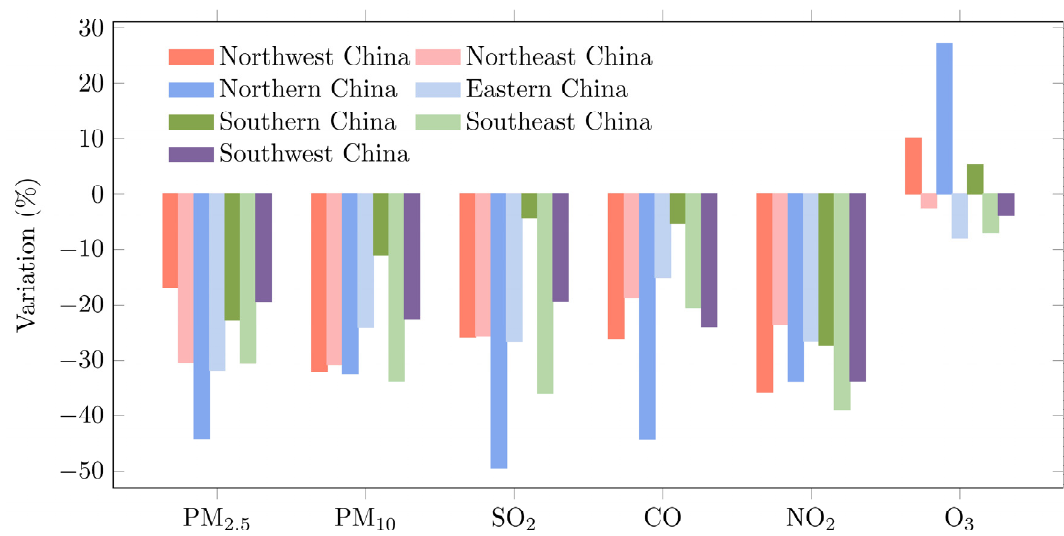
Figure 5. The variation of multiple airborne pollutants in different regions.